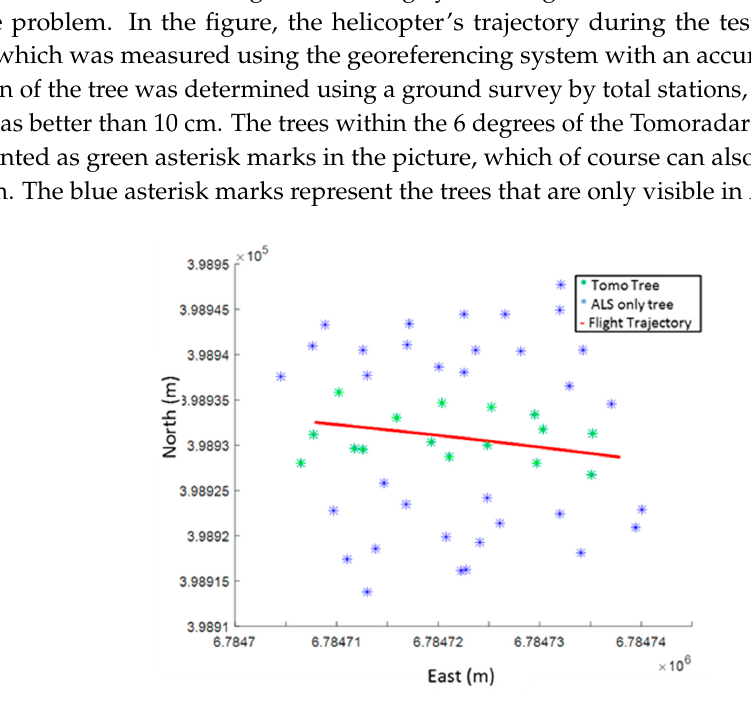
Figure 11. Tree positions at the Evo site observed by Tomoradar and ALS.